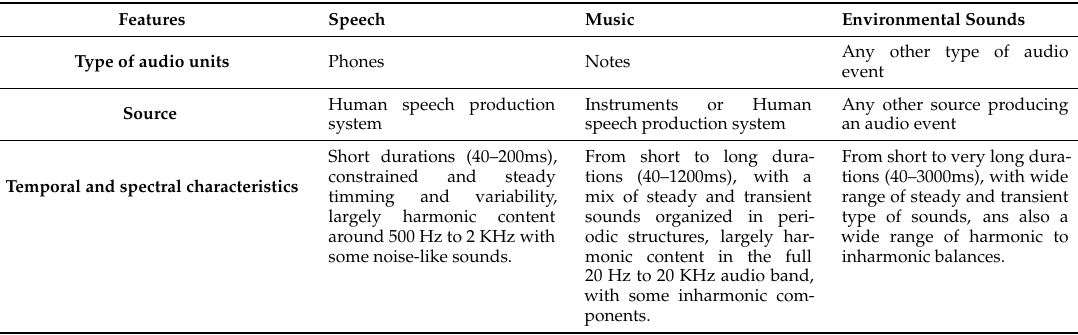
Table 1. List of features that characterize speech, music and environmental sounds (adapted from